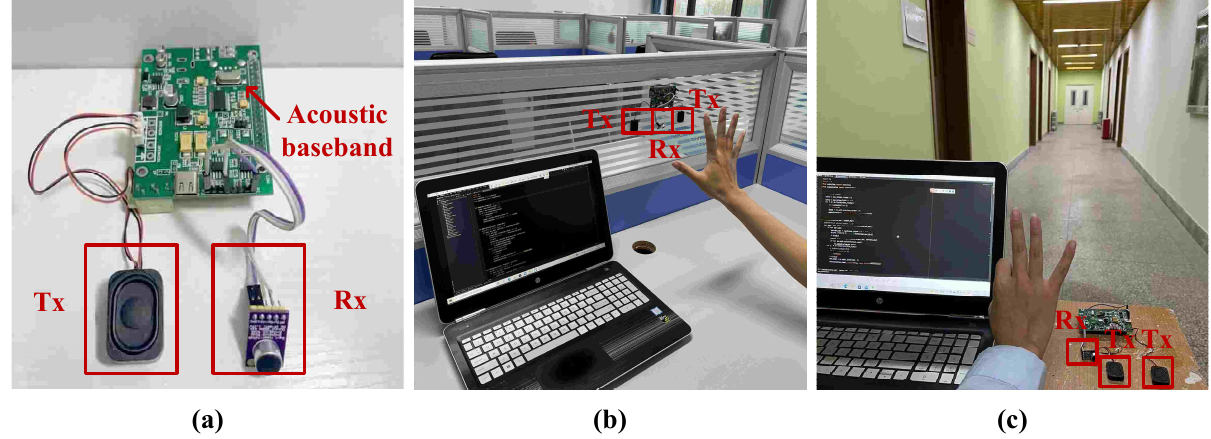
Figure 8. Experimental equipment and environment. ( a ) Data collection equipment; ( b ) Laboratory environment; ( c ) Corridor